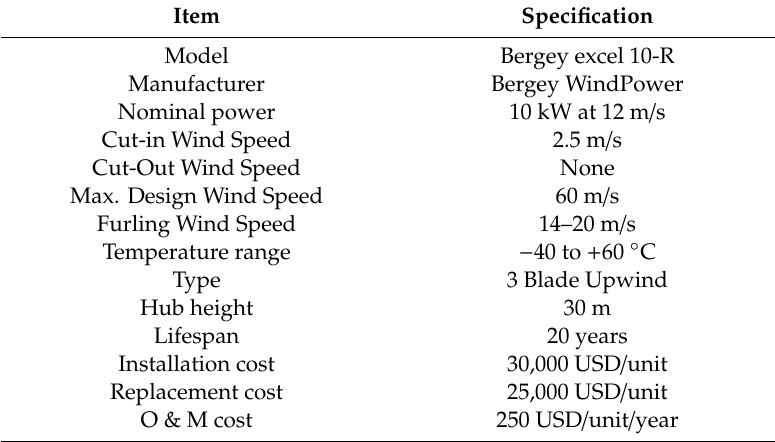
Table 5. Technical and economic specifications of the selected wind turbine model